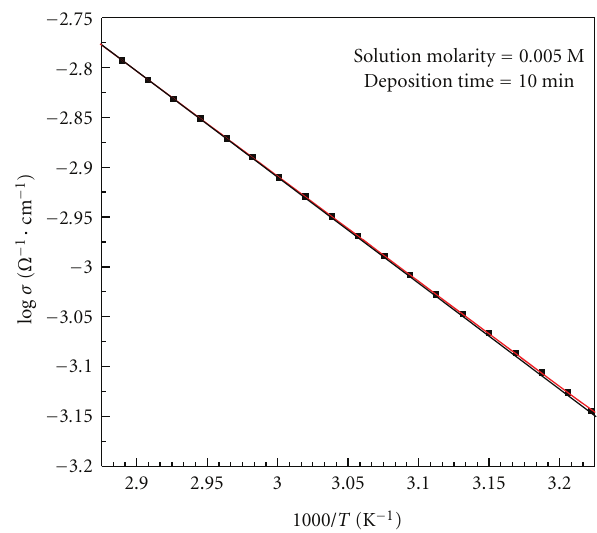
Figure 5: Plots of Log σ versus 1000/ T for IrO 2 thin